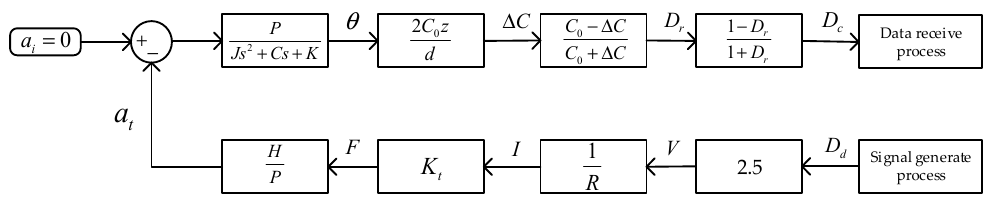
Figure 3. Diagram of the open-loop transfer function.